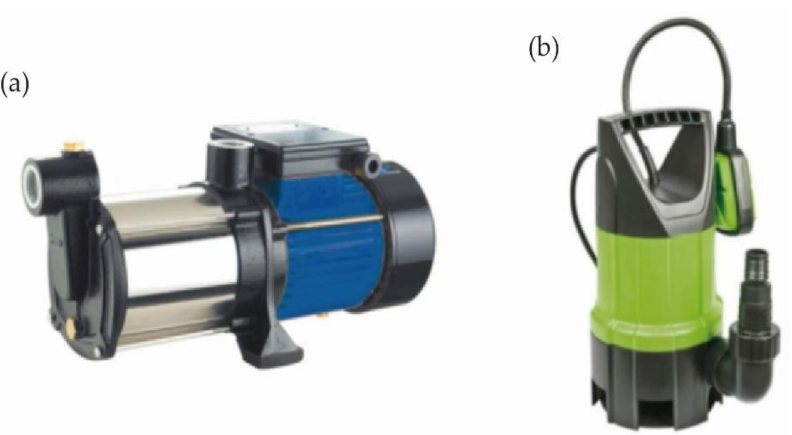
Figure 4. Pumps: ( a ) model EH-125 HIDROBEX and ( b ) model LISTA Hidrosub AS-216. A hose attached to a water flow was used to fill the tanks connected to the main